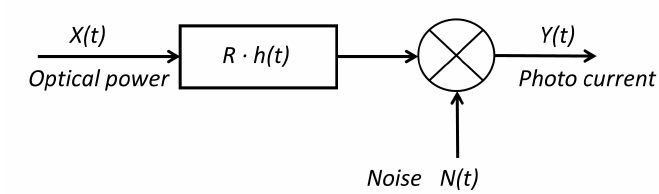
Figure 1. Optical channel modeled as a base band linear